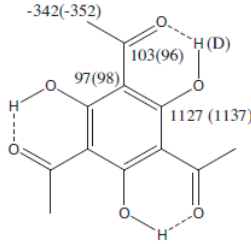
Figure 16. Deuterium isotope effects in CDCl 3 + CD 3 OD and in brackets in CDCl 3 . The values are the sums of deuteration at all OH sites. Reprinted with permission from Ref. [44]. Copyright 2014 Elsevier.